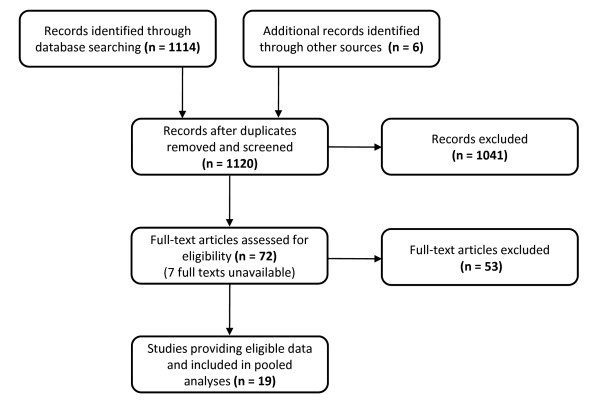
Flow diagram of the study selection process for systematic review.